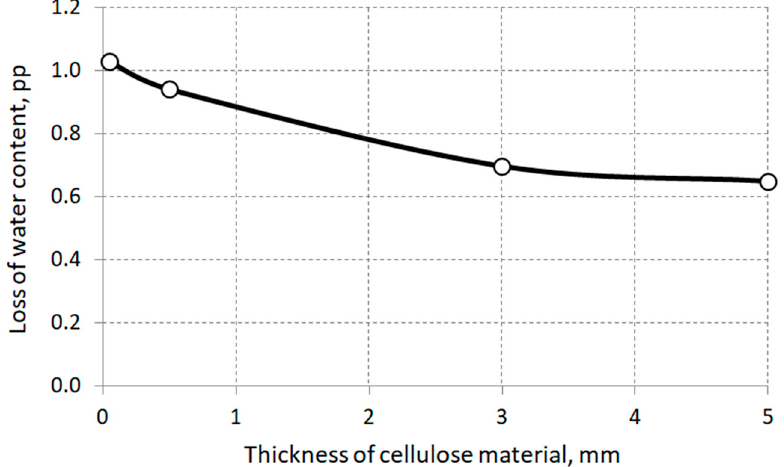
Figure 5. Loss of water content in cellulose samples after drying by means of synthetic ester (170 h, 70 °C) in dependence on their thickness; initial water content in cellulose materials was equal to about 3%.